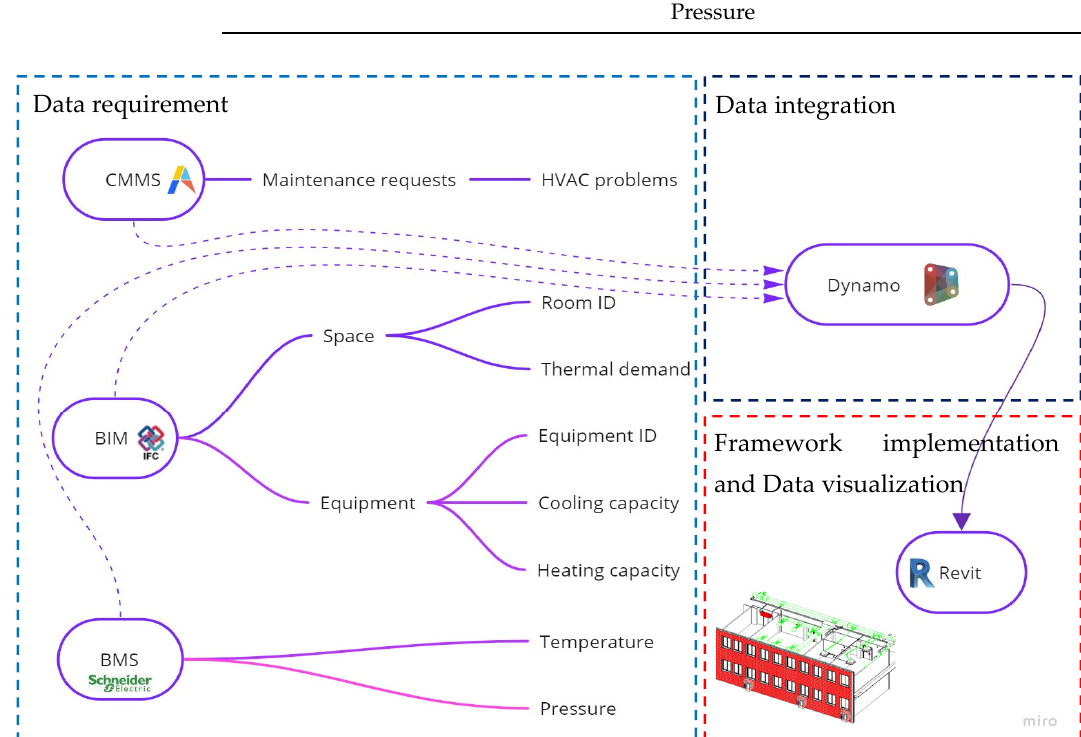
Figure 2. Process of framework implementation and data visualization.